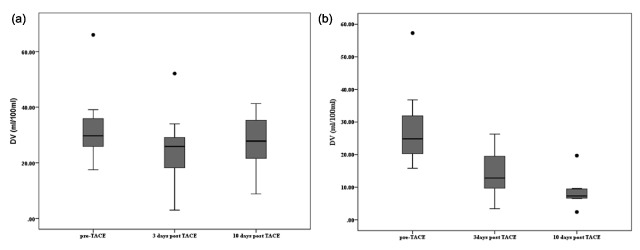
(a) Responder lesions, (b) non-responder lesions. DV was significantly reduced in all patients after initial TACE (p < 0.001). In responder lesions DV fell progressively at both 3 days and 10 days post-TACE (p < 0.001). DV in non-responders was not significantly different from pre-TACE values at 10 days (p = 0.025). Boxplot shows as follows. Upper, middle and lower line in the box shows upper quartile (75 percentiles), median and lower quartile (25 percentiles), respectively. Upper whisker = upper quartile + 1.5 × IQR (interquartile range). Lower whisker = lower quartile – 1.5 × IQR (interquartile range). IQR = upper quartile (75 percentiles) – lower quartile (25 percentiles).